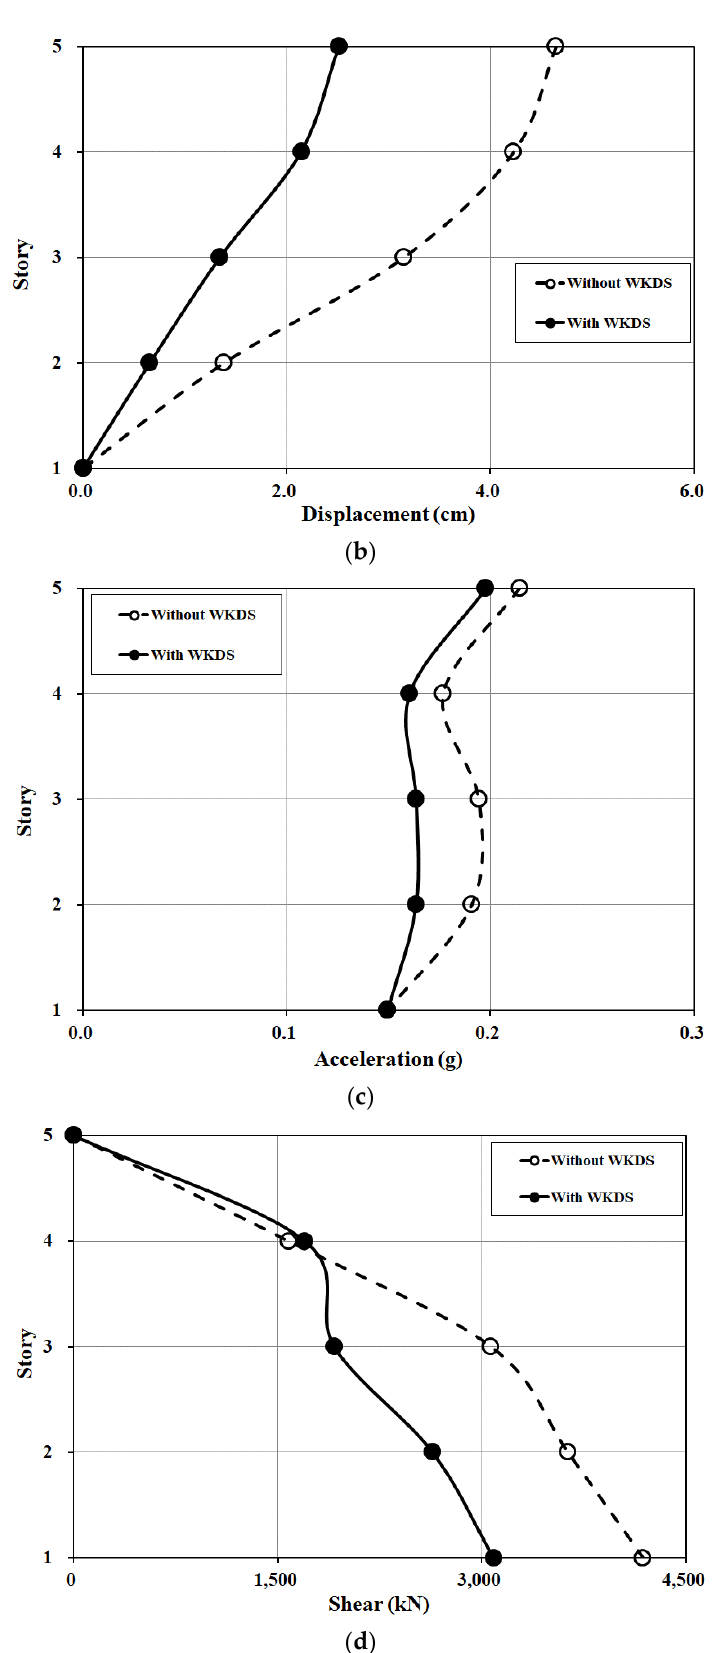
Figure 24. Responses of the unreinforced and the retrofitted structures with WKDS. ( a ) Story drift ratio, ( b ) Maximum displacement, ( c ) Maximum acceleration, ( d ) Story shear,.